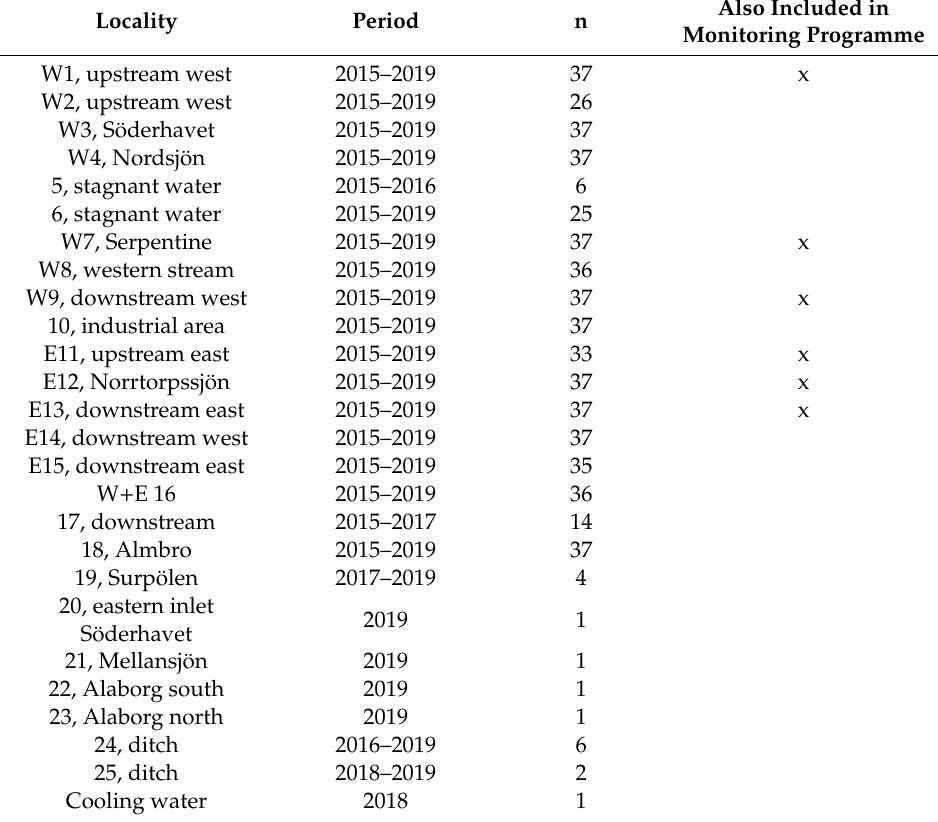
Table 1. Sampling localities, sampling period and number of sampling occasions. Also Included Period n